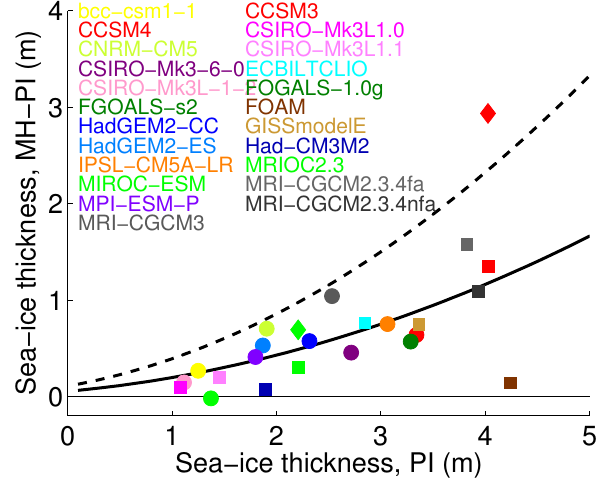
Fig. 3. Annual mean sea-ice thickness in the PI north of 80 ◦ N ver- sus the change in annual mean ice thickness from mid-Holocene to pre-industrial. The PMIP2 models are shown as squares and the PMIP3 models as circles. The PMIP3 models are listed in the left column, PMIP2 in the right column. Also included are the thickness changes for 2 × CO 2 to pre-industrial (diamonds). The lines repre- sent the thickness change as determined from the simple model de- scribed in Sect. 3. The solid line represents the MH forcing (a 0.2m summer melt increase) and the dashed line represents the 2 × CO 2 forcing (a 0.4m summer melt